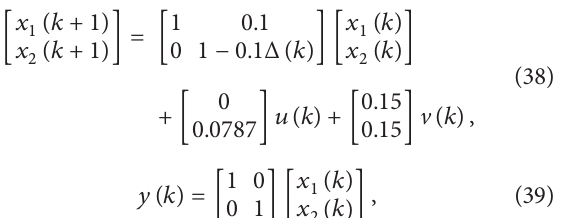
Algorithm 6. In this example, four sequences of ellipsoids are computed because the polytope Ω has four vertices.